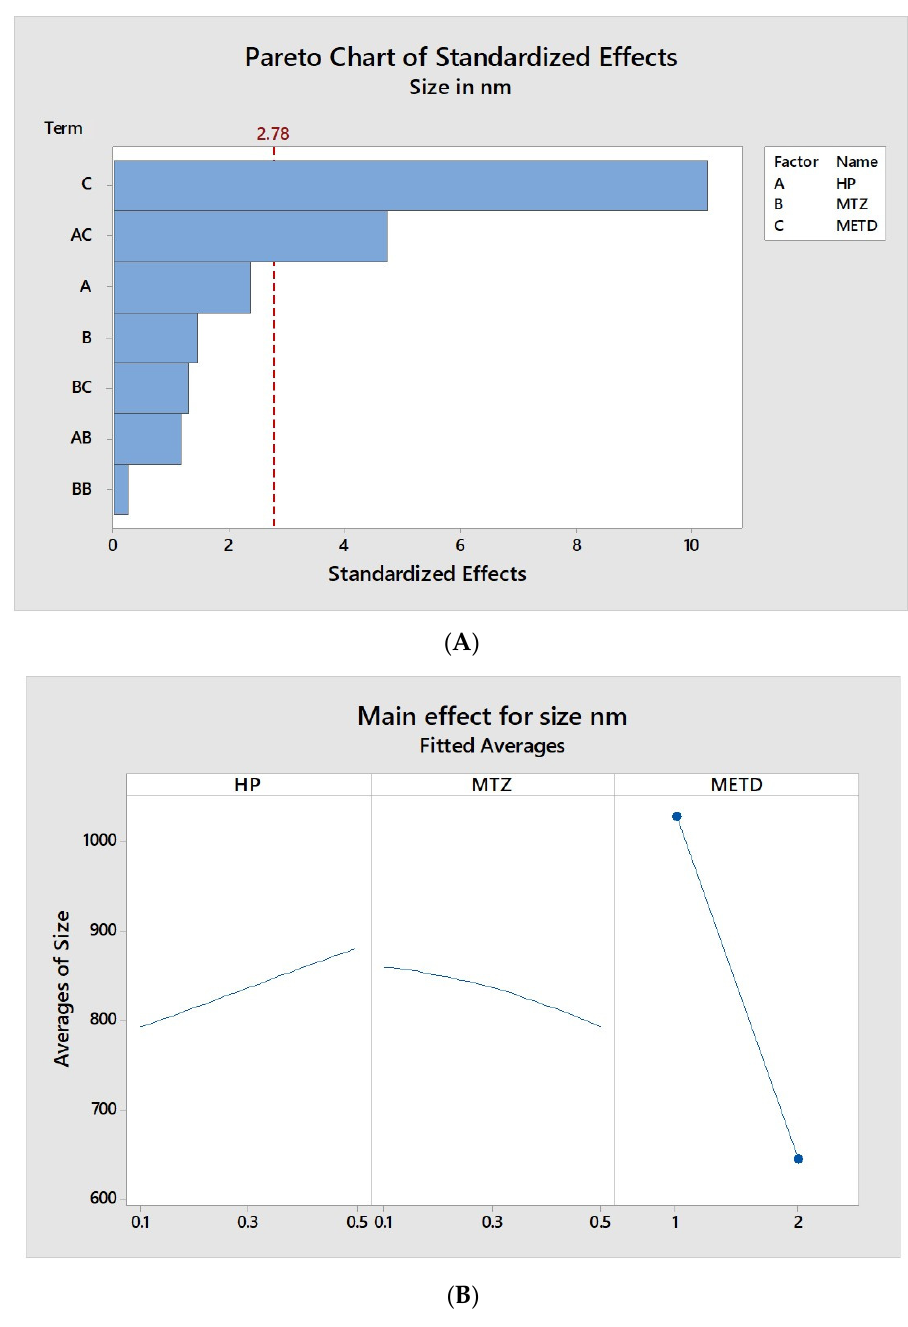
Figure 2. Graphic representation of factor influences on average size of particles. ( A ) Standardized Pareto chart estimating the effect of mass ratio HP, mass ratio MT, method, and their interaction on the size of the particles. The red dashed vertical line represents the 0.05 critical value for ANOVA. All bars extending to the right of this line indicate that the effects are statistically significant at 5% significance level. ( B ) Isolated analysis of the factors, HP/MT concentration, and method (on X-axis), and their influence on the size of the nanoparticles (on Y-axis).